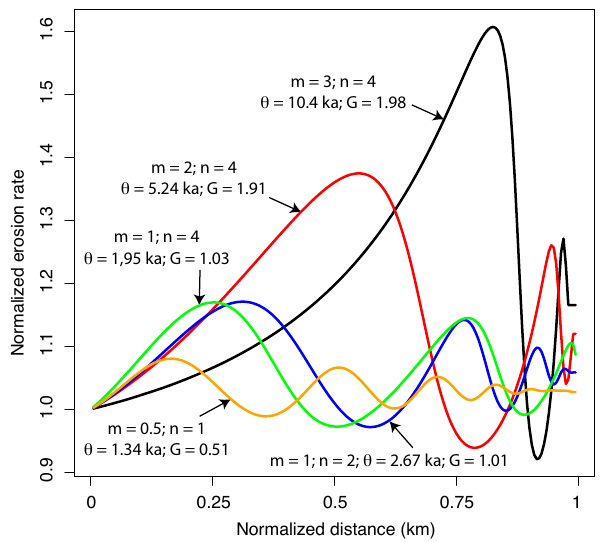
/U ) as a function ∂t